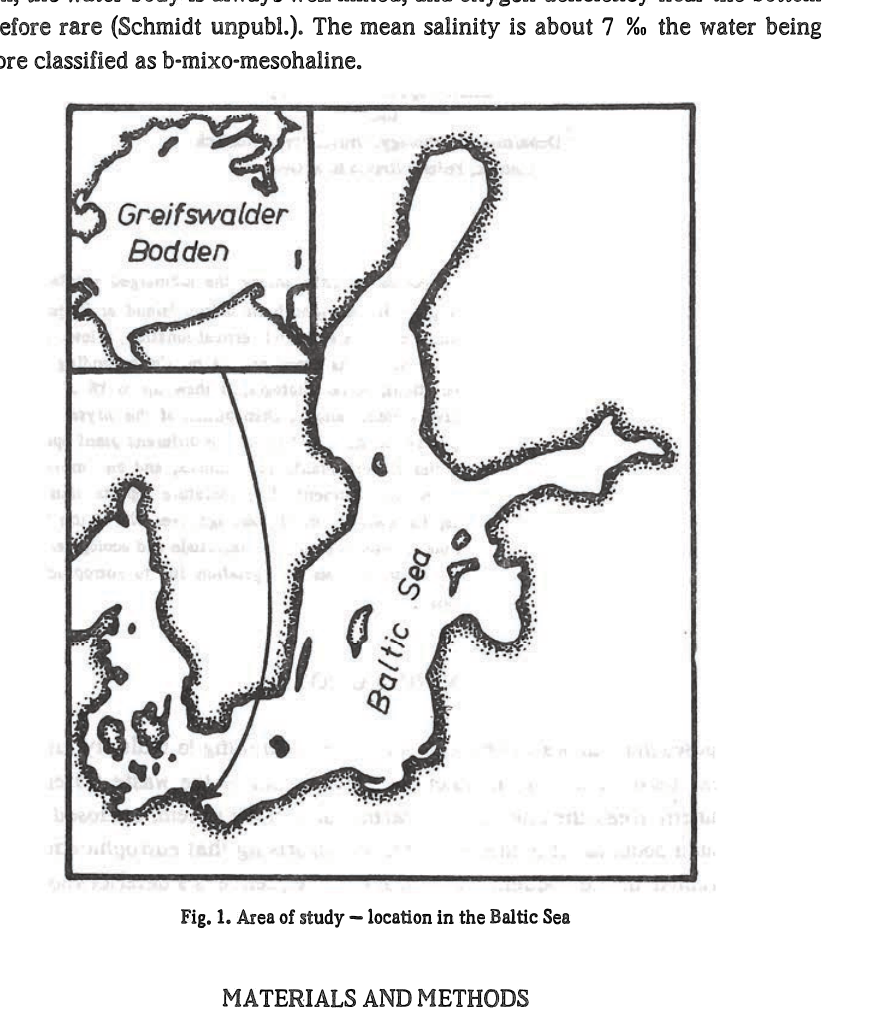
Fig. 1. Area of study -location in the Baltic